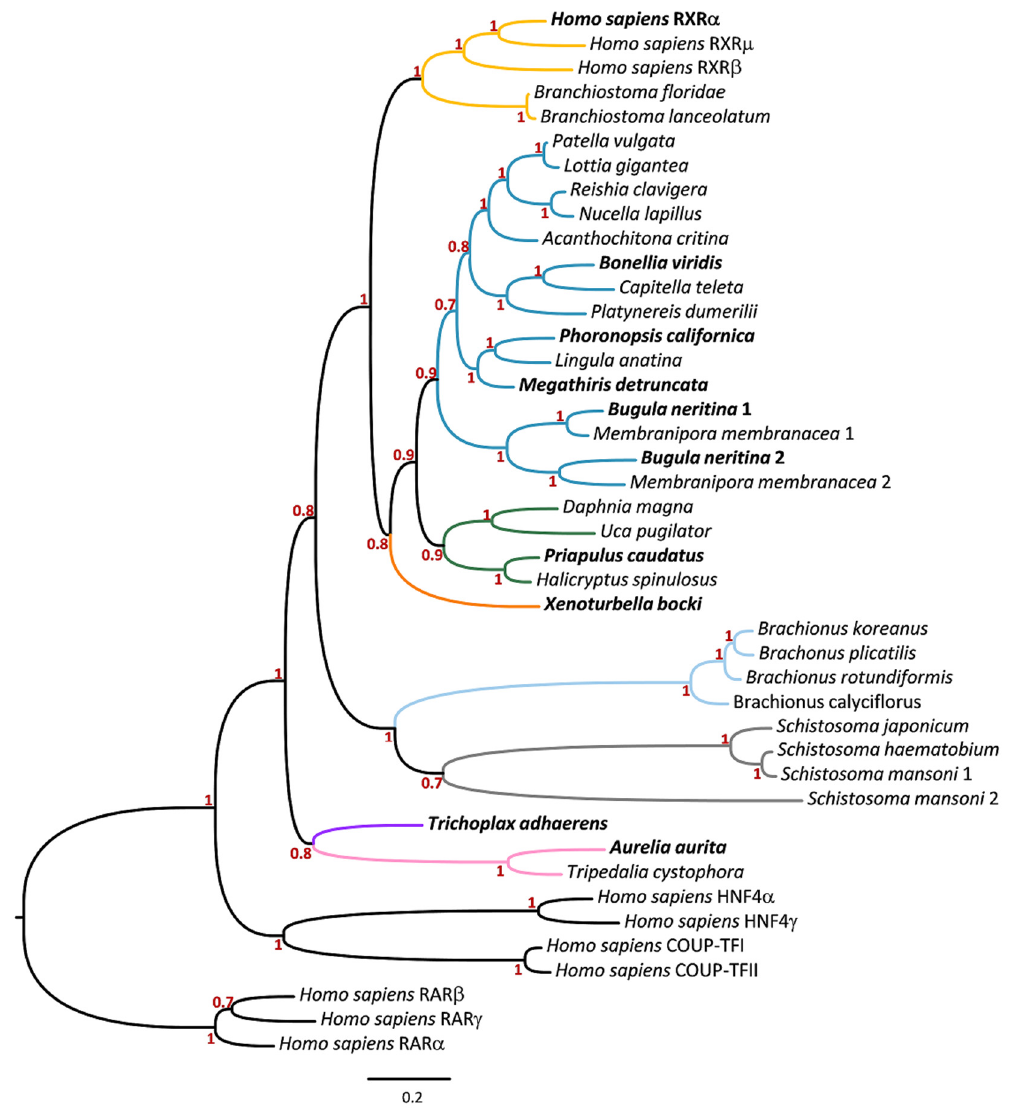
Figure 1. Bayesian analysis of the phylogenetic distribution of RXR among metazoan lineages. Chordata (yellow); Lophotrochozoa (blue): Mollusca, Annelida, Phoronida, Brachiopoda, and Bryozoa, Platyhelminthes (grey), Rotifera (light blue); Ecdysozoa (green): Arthropoda and Priapulida; Xenoturbellida (orange); Placozoa (purple); Cnidaria (pink); numbers at nodes indicate Bayesian posterior probabilities. Human retinoic acid receptor (RAR) amino acid sequences were used as outgroup to root the tree. The RXRs used in the subsequent functional analysis are highlighted in bold.